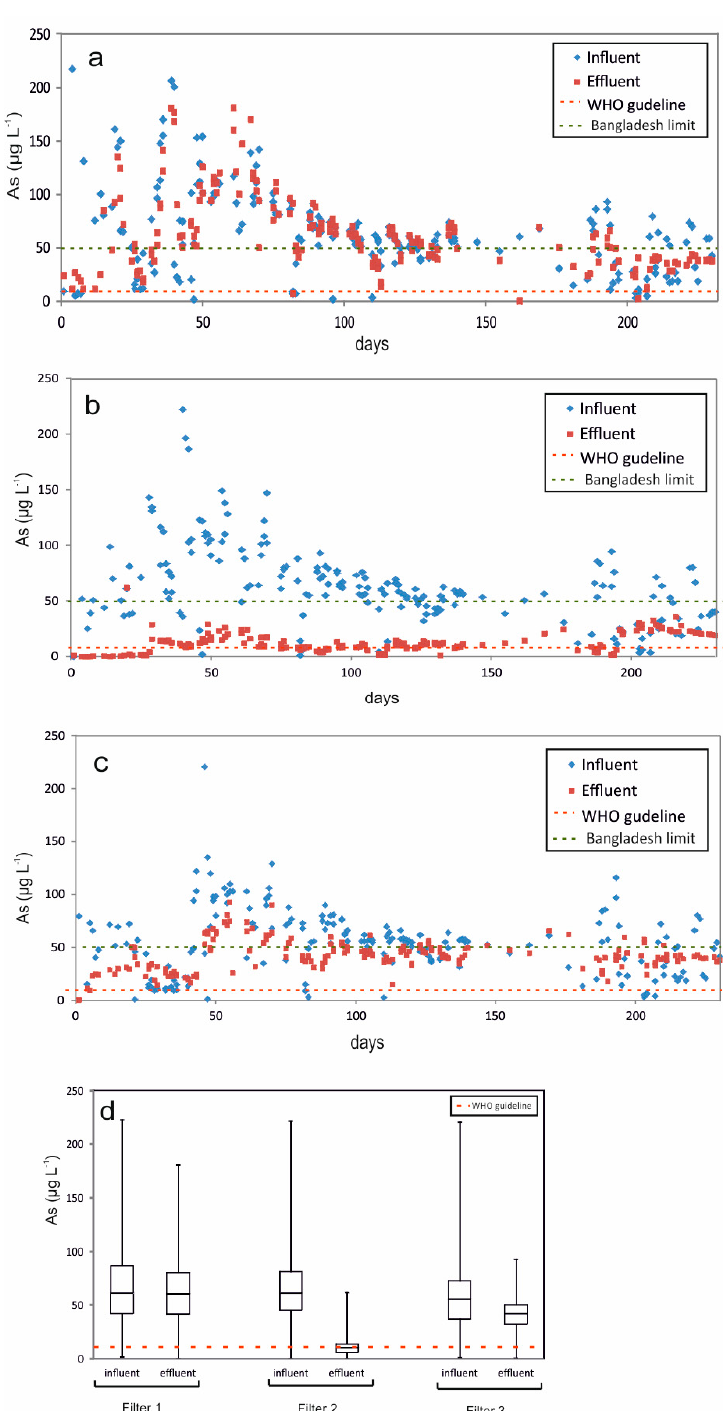
Figure 2. Arsenic removal by three different mixed-media slow-sand filters: concentrations measured throughout the experimental period in ( a ) reference filter, ( b ) CIM filter, ( c ) ICS filter and ( d ) boxplots summarizing results presented in plots ( a – c ).